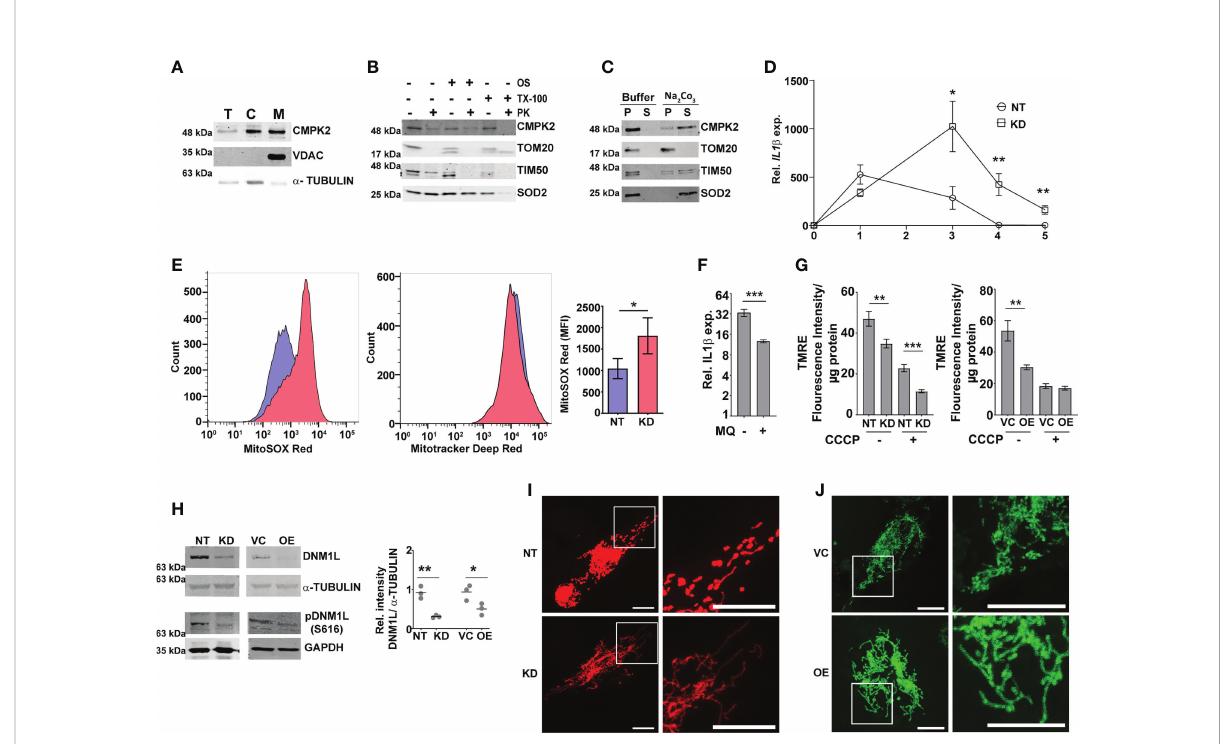
FIGURE 3 Modulation of CMPK2 affects the mitochondrial physiology in macrophages. (A) Expression of CMPK2 in subcellular fractions of THP1 macrophages by immunoblotting with speci fi c antibodies: T, total cell extract; C, cytoplasmic fraction; M, mitochondria. Expression of cytosolic protein a -TUBULIN and mitochondria resident protein VDAC is also represented. Blots are representative of three independent experiments. (B) Mitochondrial fraction was subjected to Proteinase K treatment in the presence or absence of Triton X-100 and given osmotic shock (OS) and analyzed by immunoblotting. Data are representative of three independent experiments. (C) Mitochondrial fraction was incubated with mitochondrial buffer with and without Na 2 CO 3 and centrifuged at 13,000 rpm for 15 min. The pellet (P) and supernatant (S) fractions were immunoblotted. Data are representative of three independent experiments. (D) Kinetic pro fi le of IL1 b expression in NT and KD during differentiation of monocytes to macrophages. Expression was checked at different time intervals after PMA treatment. Values are mean fold change in expression with respect to GAPDH + SEM triplicate assays of N = 3 experiments. (E) Analysis of mitochondrial ROS in NT or KD macrophages. Cells were stained with MitoTracker Deep Red (as an internal control), and ROS-speci fi c MitoSOX Red and speci fi c populations were quanti fi ed by FACS. The histogram plots of a representative experiment of N = 4 are depicted. The extent of MitoSOX red mean fl uorescence intensity (MFI) + SEM is represented graphically in the inset. (F) Expression of IL1 b in the macrophages with the addition of a